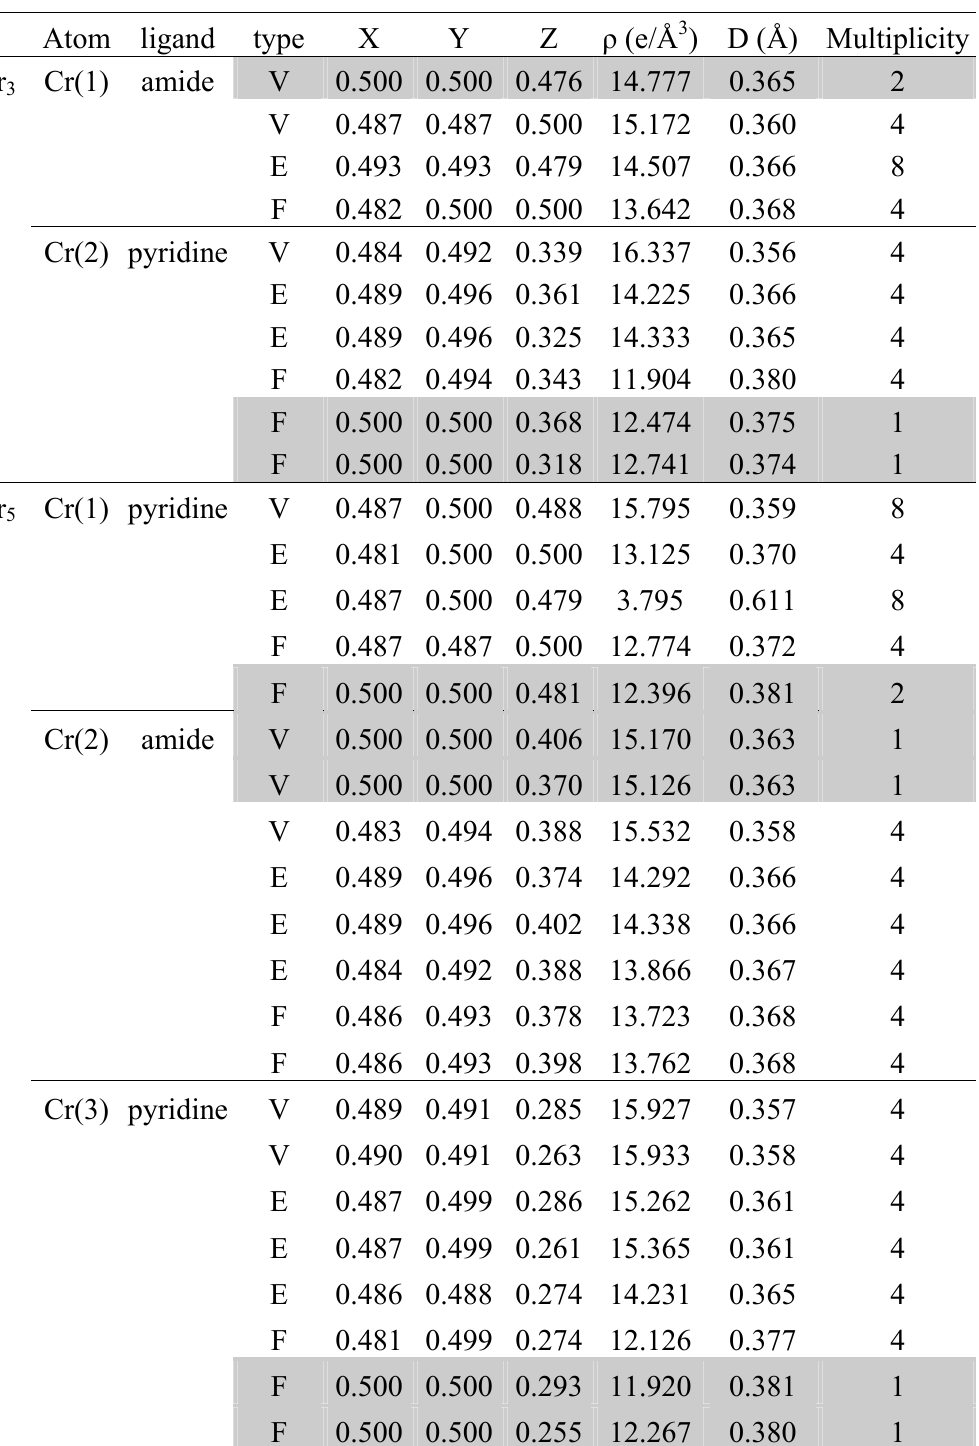
Table 6 Atomic graphs of all the calculated models along the Cr chain. The third column indicates the type of nitrogen atom, which the Cr ion in the second column connects to. The type of the critical points around a Cr ion is indicated in the fourth column and the locations of the critical points are shown from the fifth to seventh column in fractional coordinate. The electron density of the critical point is shown in the eighth column. The ninth column shows the displacement of the critical point from the Cr ion. The last column indicates the multiplicity of the critical points in the unit cell. The shade rows are those critical points facing neighboring Cr ions. The Euler’s polyhedral formula V + F - E = 2 is satisfied in each Cr